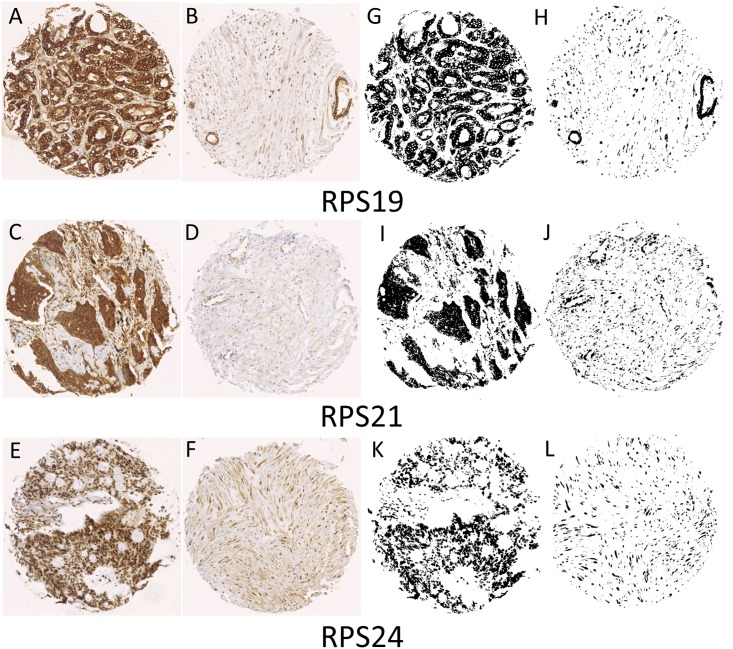
Representative staining for three RPS proteins in malignant human prostate carcinoma tissue (A, C, E) vs non-malignant human tissue (B, D, F). Human prostate tissue samples were obtained from 82 patients and a tissue array was constructed, containing 245 cores, and imaged using a Nikon DXM 1200 digital imaging system with a Nikon Diaphot at 20x magnification and standard bright-field settings. Images of each individual tissue core (3840x3072 pixels) were then used for quantification of the Ox-DAB signal using ImageJ software (see Materials and methods- Signal quantification). Binary, segmented images (G, H, I, J, K, L) represent pixels that were positive for each representative antibody.